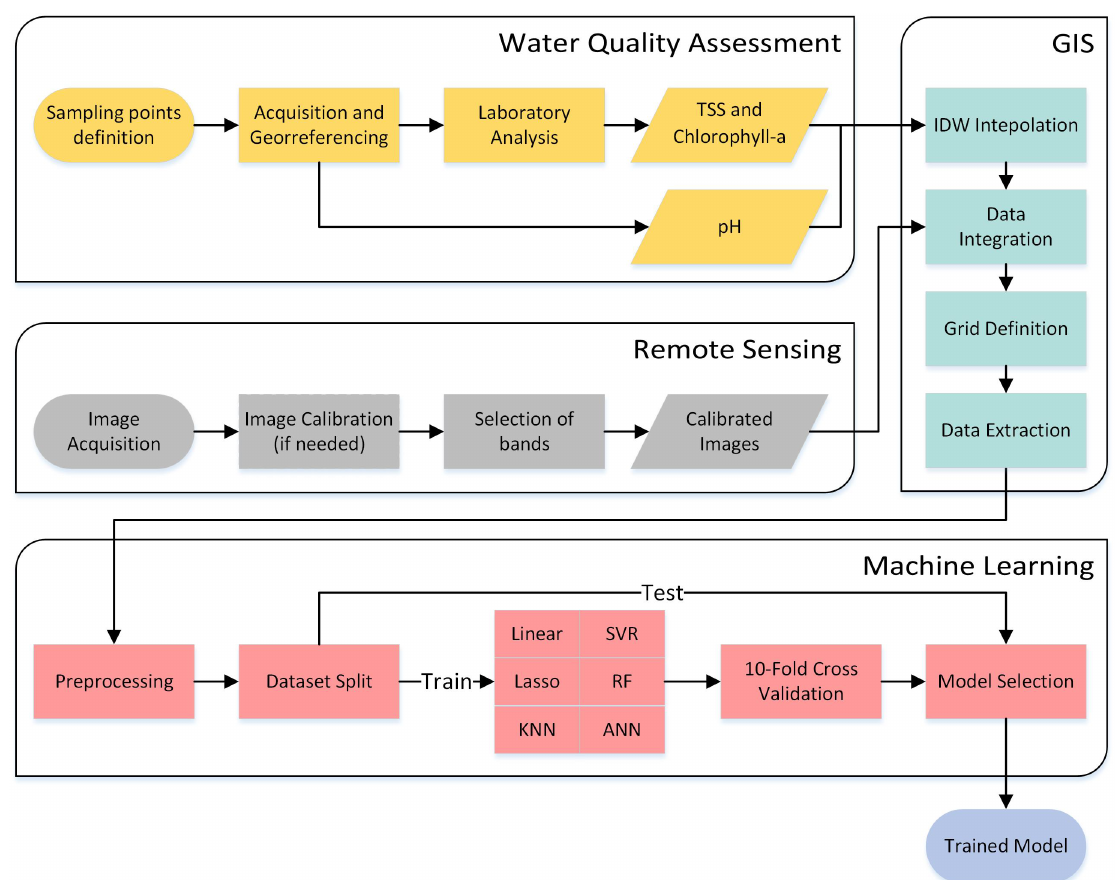
Figure 1. Flowchart of the proposed